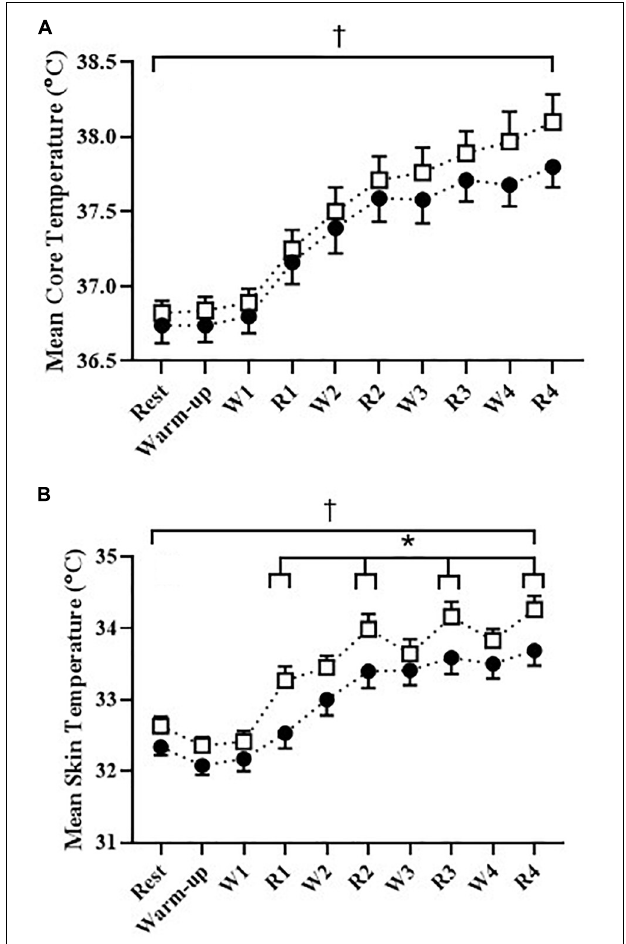
FIGURE 3 | (A) Core body temperature ( ◦ C) ( n = 10) and (B) mean skin temperature ( ◦ C) ( n = 10) for CON R ( • ) and ECC R ( (cid:3) ) trials during seated rest, warm-up (60 watts), high intensity interval work (60% PPO, W1–W4) and recovery periods ( CON R 30%, ECC R 60% PPO, R1–R4). * P < 0.05 ECC R recovery versus CON R recovery periods. † P < 0.05 rest versus end trial (R4). Data is expressed as mean ± SEM.